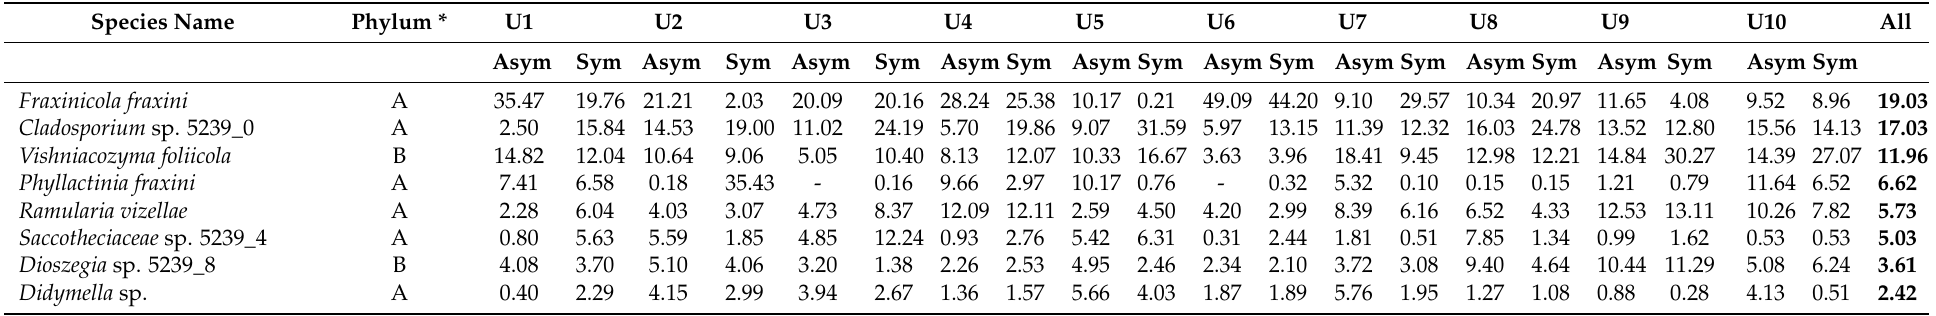
Table 4. Occurrence and relative abundance (%) of the 40 most common fungal taxa (shown as a proportion of all high-quality fungal sequences) in asymptomatic and symptomatic leaf samples in ten populations of Fraxinus excelsior in